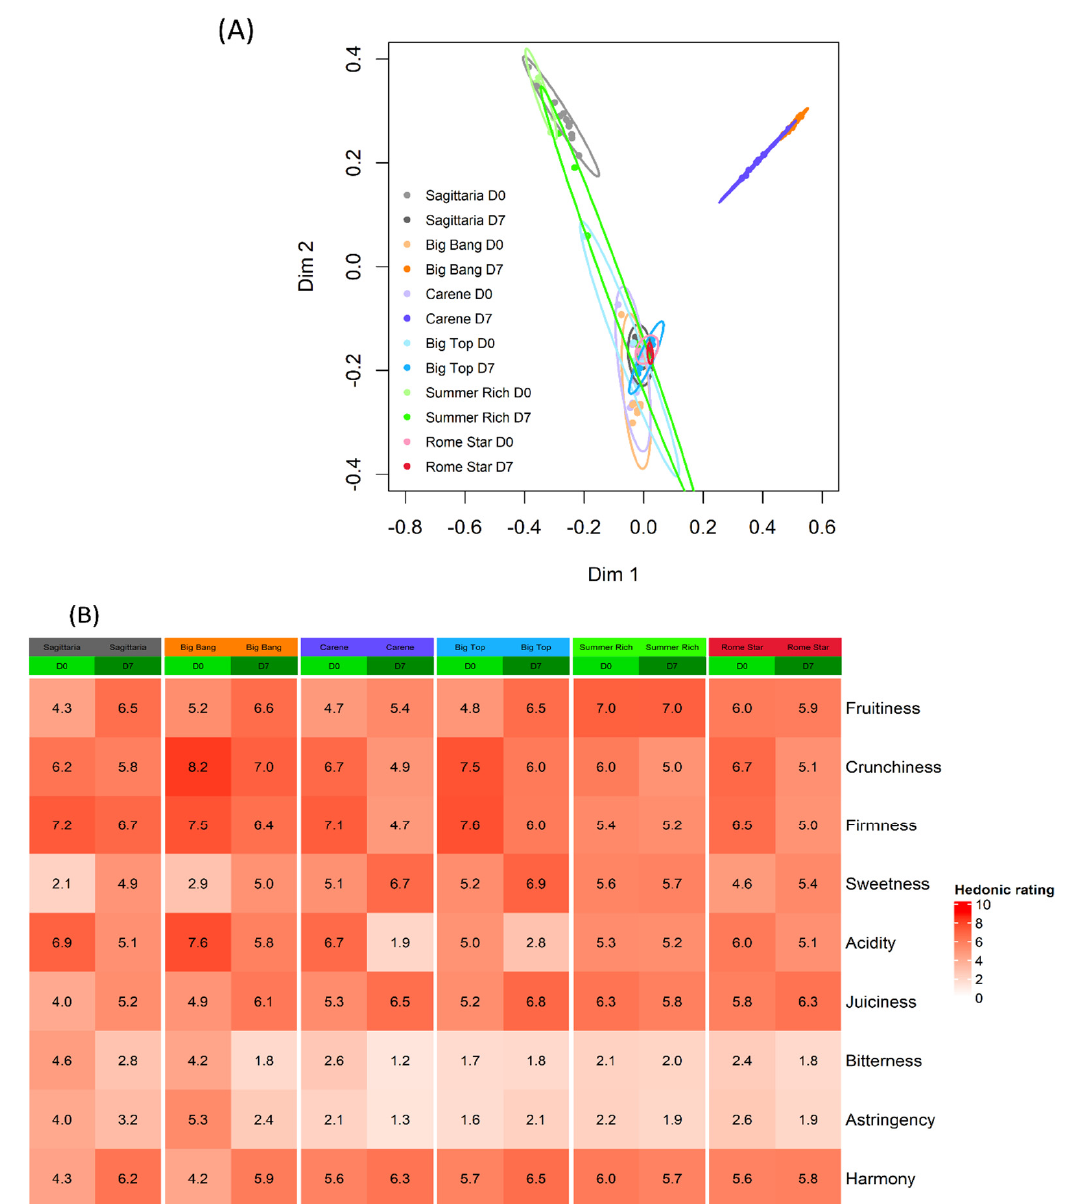
Figure 2. Sensory descriptor variation among cultivars. Fruitiness, crunchiness, firmness, sweetness, acidity, juiciness, bitterness, astringency and harmony were evaluated by a team of trained panellists before (D0) and after (D7) storage; storage was for 7 days at 1 ◦ C followed by a 36 h recovery at 20 ◦ C. Cultivars are shown in order of ripening. ( A ) MDS based on the Random Forest cultivar classification proximity matrix with D0 and D7 time points separated. Each ellipse represents the 95% confidence interval. ( B ) Heatmap of the mean value of each sensory descriptor for each cultivar/storage combination.